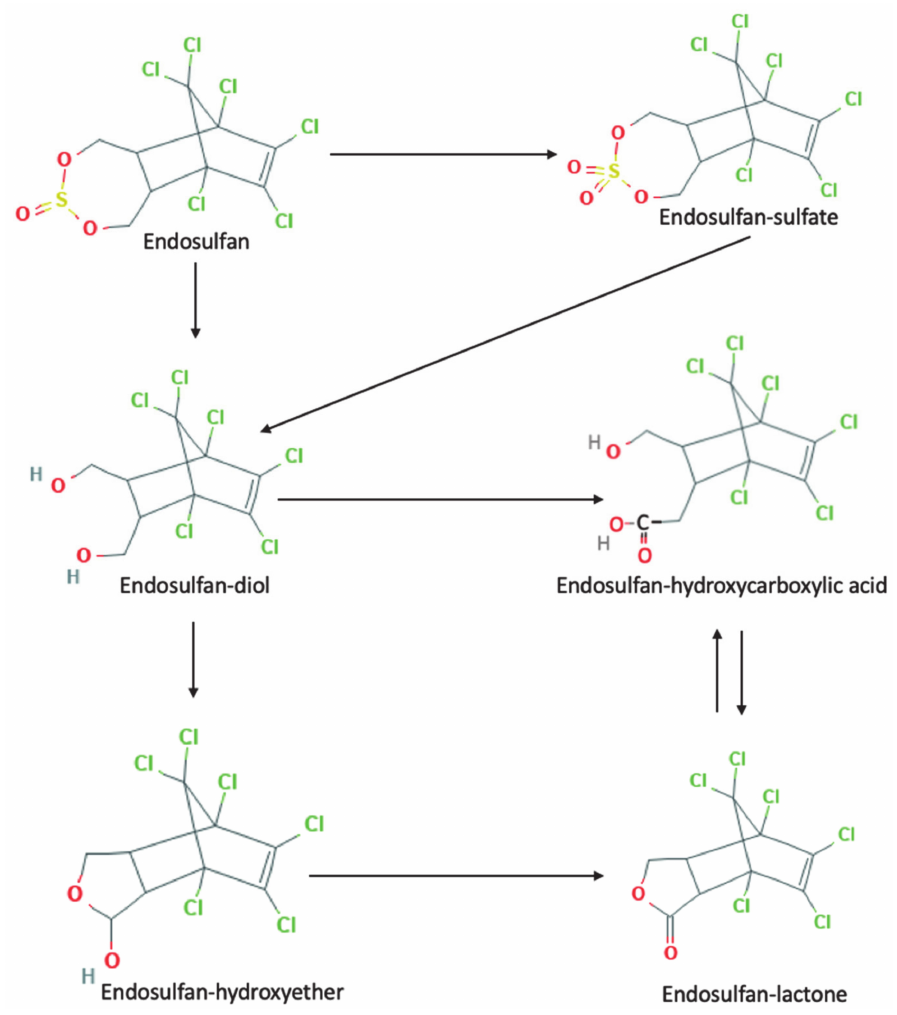
Figure 1. Degradation of endosulfan pesticide to endosulfan lactone